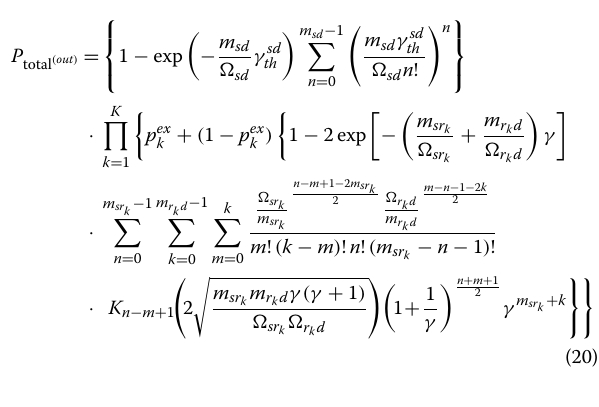
Fig. 4 Outage probability of dual hop energy-harvesting AF relay-aided systems with m sd = 3, m s